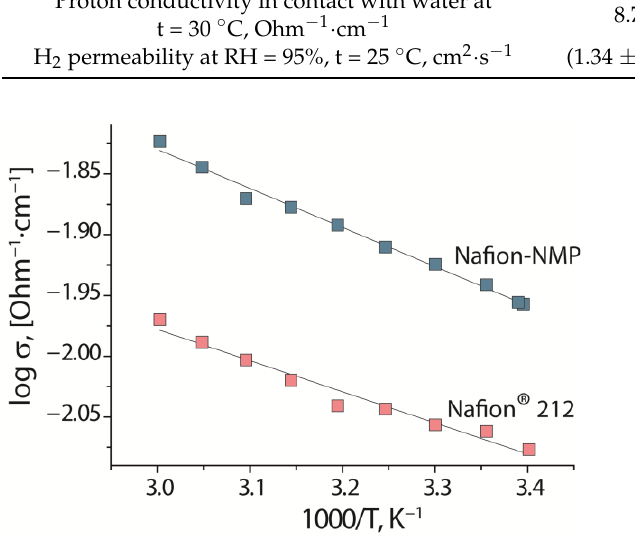
Table 2. Data on water uptake, proton conductivity, and hydrogen permeability of the studied membranes. Nafion ® 212 Nafion-NMP Water uptake in contact with water, wt.% Water uptake at RH = 32%, wt.%